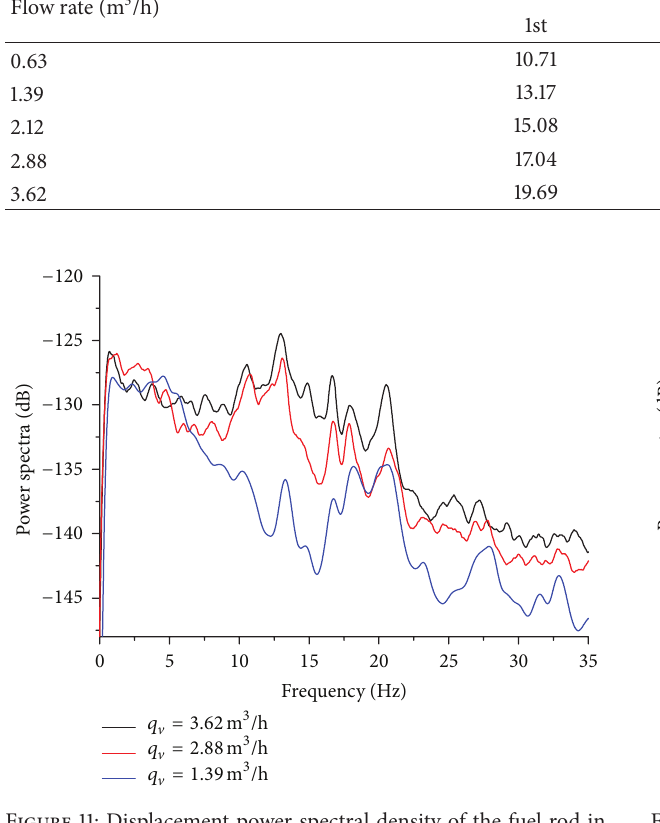
Figure 12: Displacement power spectral density of the fuel rod in blind hole case.